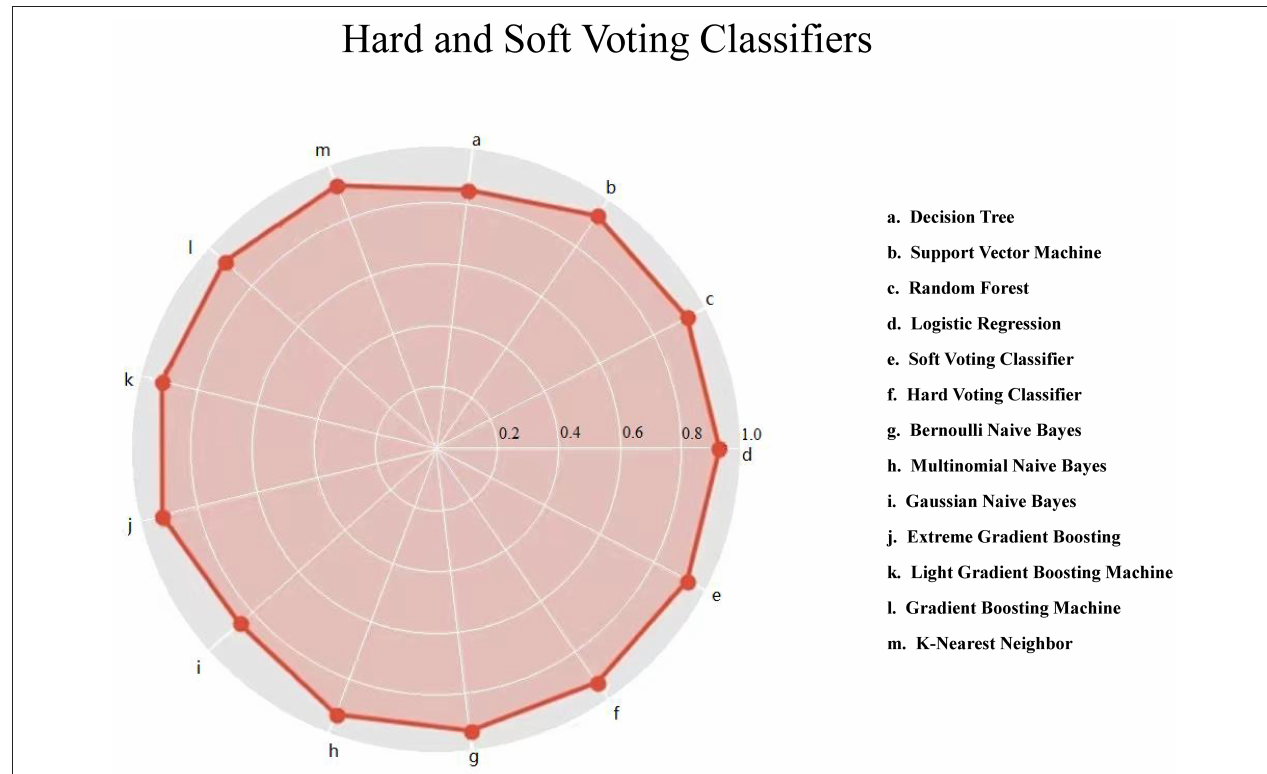
FIGURE 1 | Hard and soft voting classifications based on 11 machine-learning algorithms for lower respiratory tract infection. The red solid circle represents the accuracy.